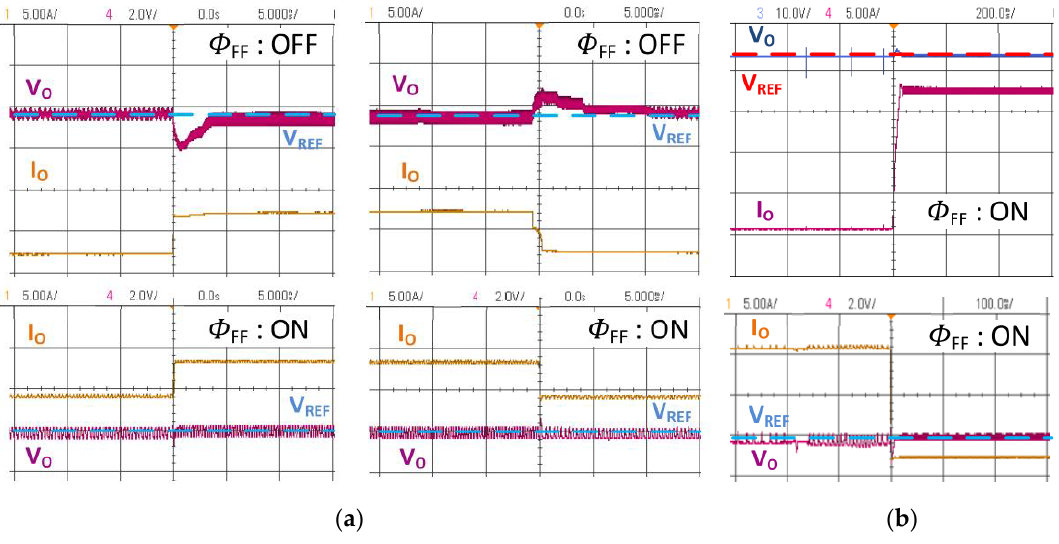
Figure 12. Scope snapshots of output voltage variation in the presence of abrupt and large step changes in the load (±5 A in ( a ) and ±15 A in ( b )), without (top) and with (bottom) feed-forward loop,